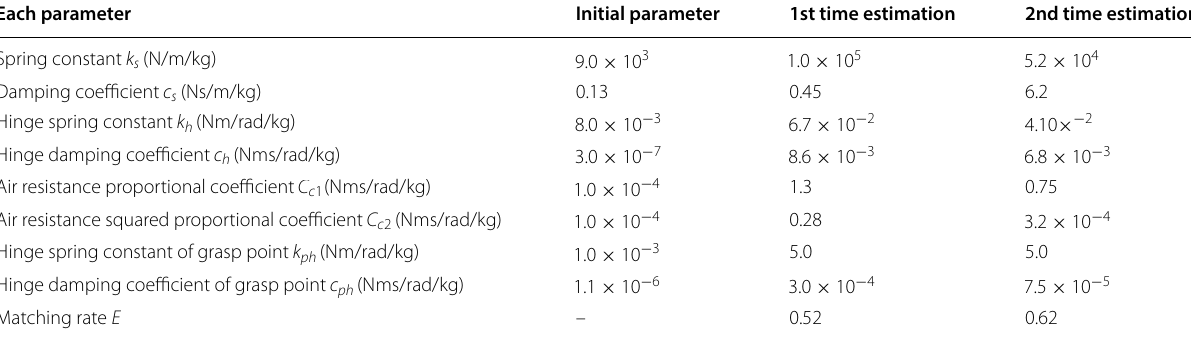
Table 3 Estimated parameter values (desired image of string shape:d) Each